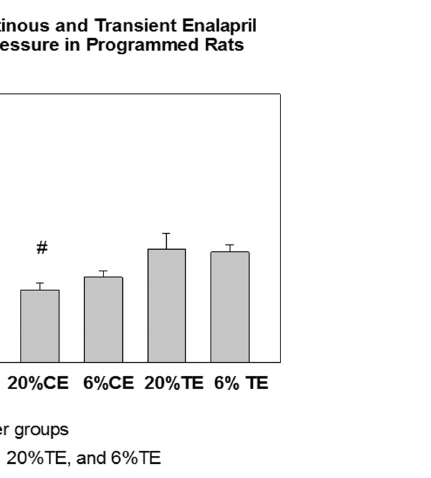
Fig 1. Effect of continuous and transient enalapril on blood pressure in control and programmed rats. Pregnant rats were given either a 20% protein diet or an isocaloric low protein diet during the last half of pregnancy. Nursing mothers were all given a 20% protein diet. Upon weaning at 3 weeks of age, rates were given enalapril (100 mg/L) or vehicle (ethanol 4 ml/L) in their drinking water. The continuous enalapril group (CE) received enalapril continuously until the time of study at 6 months of age. The transient enalapril group (TE) received enalapril from 3 – 6 weeks of age and vehicle thereafter. Blood pressure was measured by tail cuff after 4 days of training. The blood pressures were measured in a blinded fashion. The 6% group had a higher blood pressure than all the other groups. The continuous enalapril groups had a lower blood pressure than the corresponding transient enalapril group. N = 9 – 12 in each